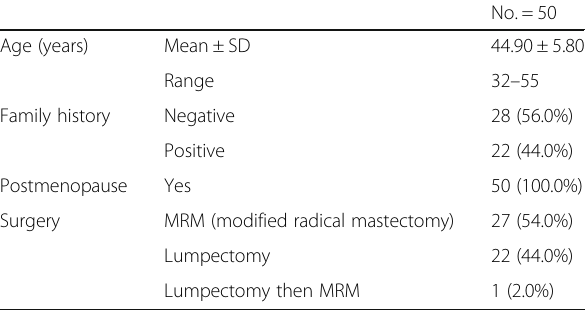
Table 1 Demographic data of the patients